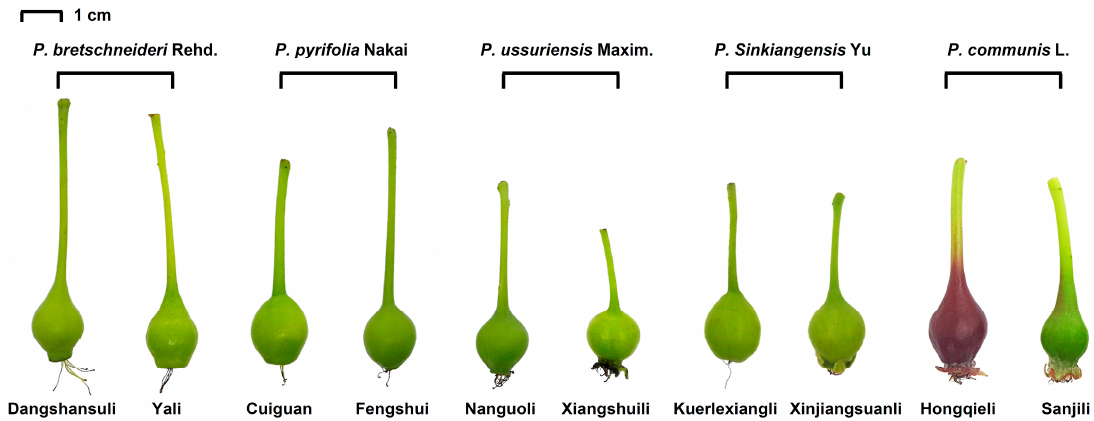
Figure 4. Visual appearance of thinned young fruits from ten pear varieties at 20 days after full bloom.